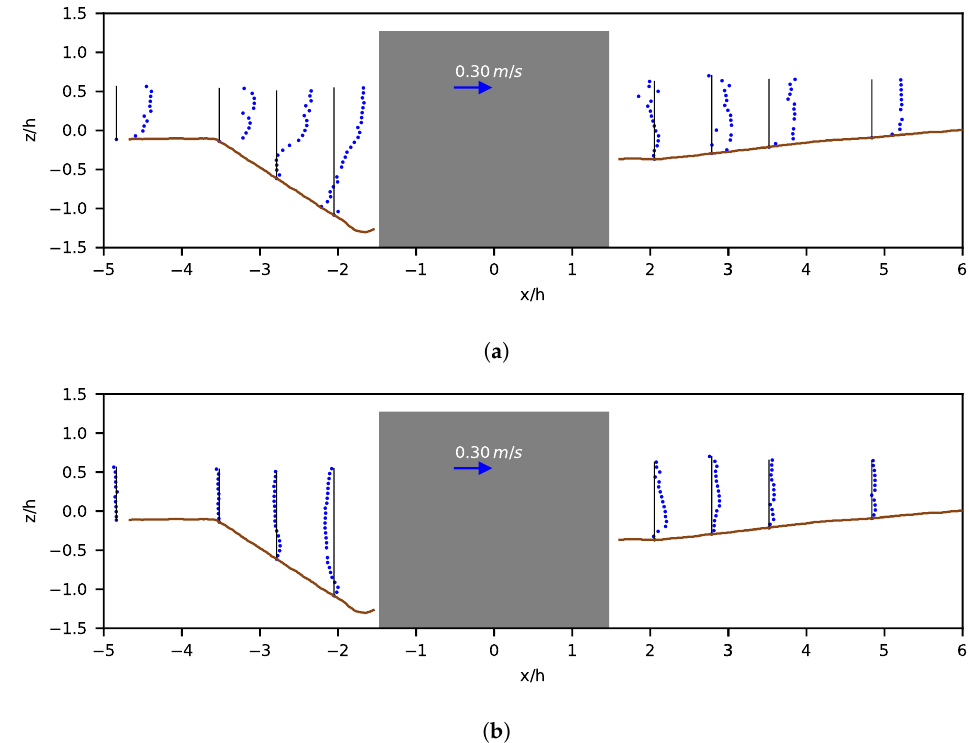
Figure 11. Vertical profiles of the velocity components along the pier’s mid-plane for Exp . 1 D Ebed . ( a ) Stream-wise component of velocity ( u ). ( b ) Vertical component of velocity ( w ).